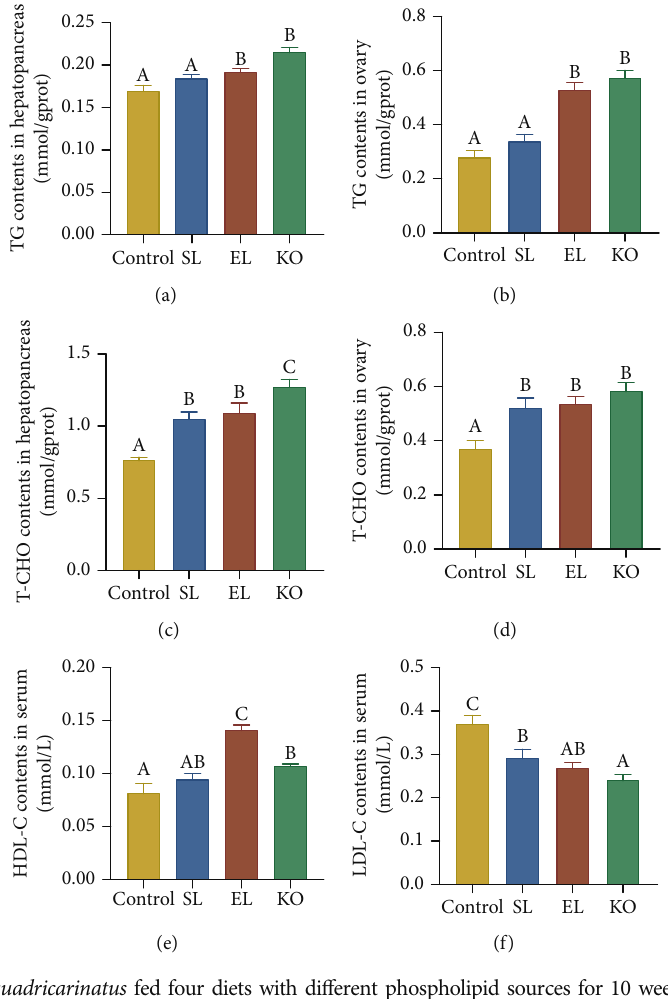
Table 2: The proportion and average diameter of late-stage yolk synthesis stage oocytes (LYO) and mature oocyte (MO) in Cherax quadricarinatus fed four diets with di ff erent phospholipid sources for 10 weeks. Parameters of LYO and MO Proportion Average diameter